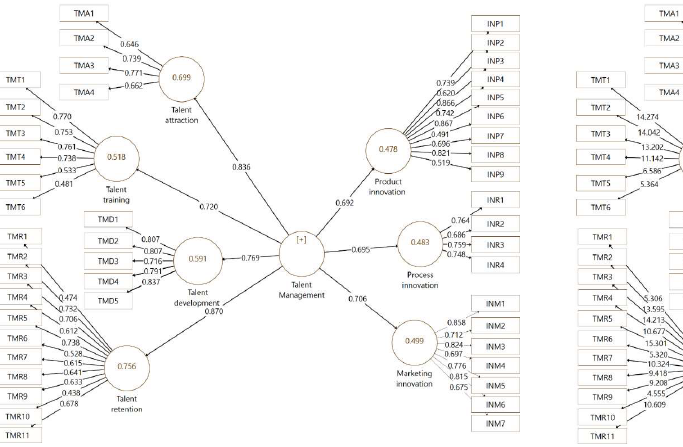
Fig. 2. Measurement model with factor loadings Fig. 3. Measurement model with effects size